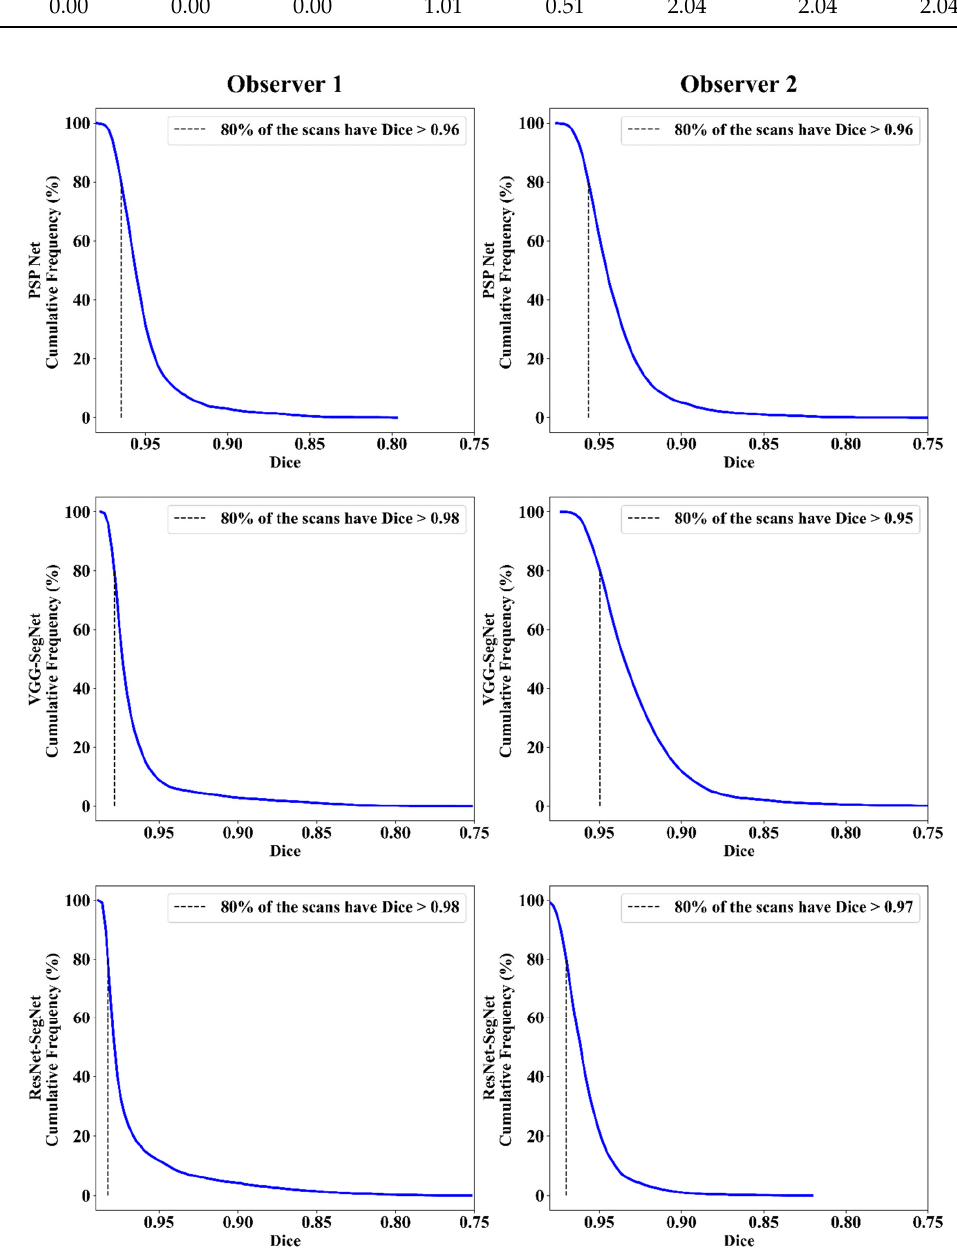
Figure 16. DS for combined lung using the three AI models: Observer 1 vs. Observer 2.